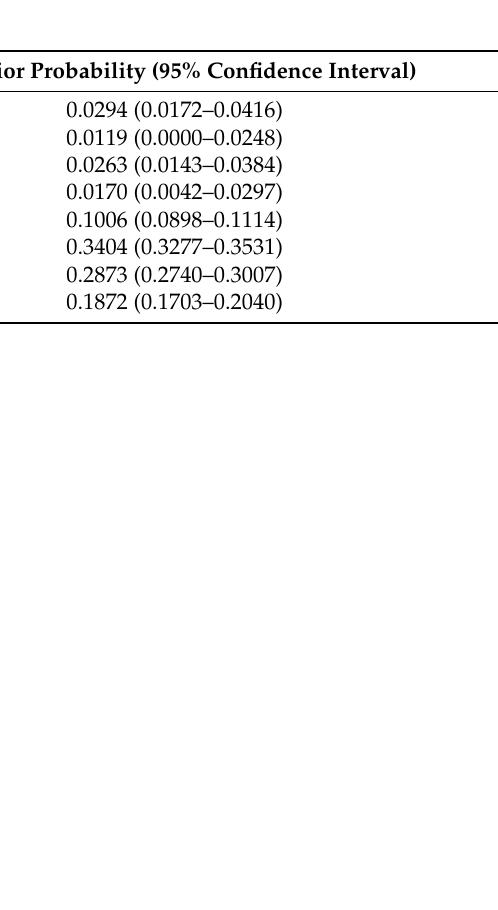
Figure 3. The evolutionary scenario with highest posterior probability for the western (W), central (C), and eastern (E) groups of Castanopsis sclerophylla based on scenario 6. The ancestral population with effective population size of N A split into the western and eastern groups at time t 5 with effective population size of N 1b and N 3b , and their effective population sizes increased at time t 4 to N W and N E . Genetic admixture occurred at time t 2 with admixture rate of r a , and the central group has the effective population size of N C . Table 7. Posterior distribution of the parameters in the hypothesized scenario 6 for the western, central, and eastern groups of Castanopsis sclerophylla .